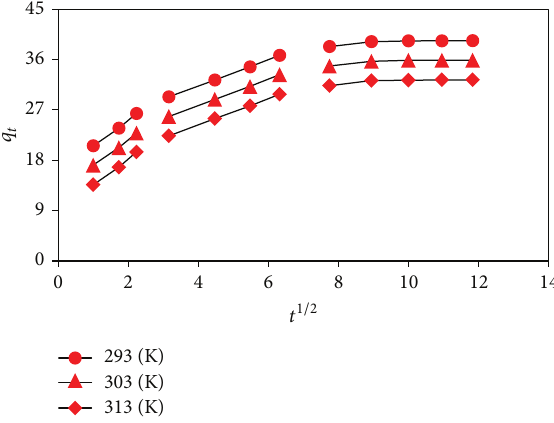
Figure 5: Intraparticle diffusion model